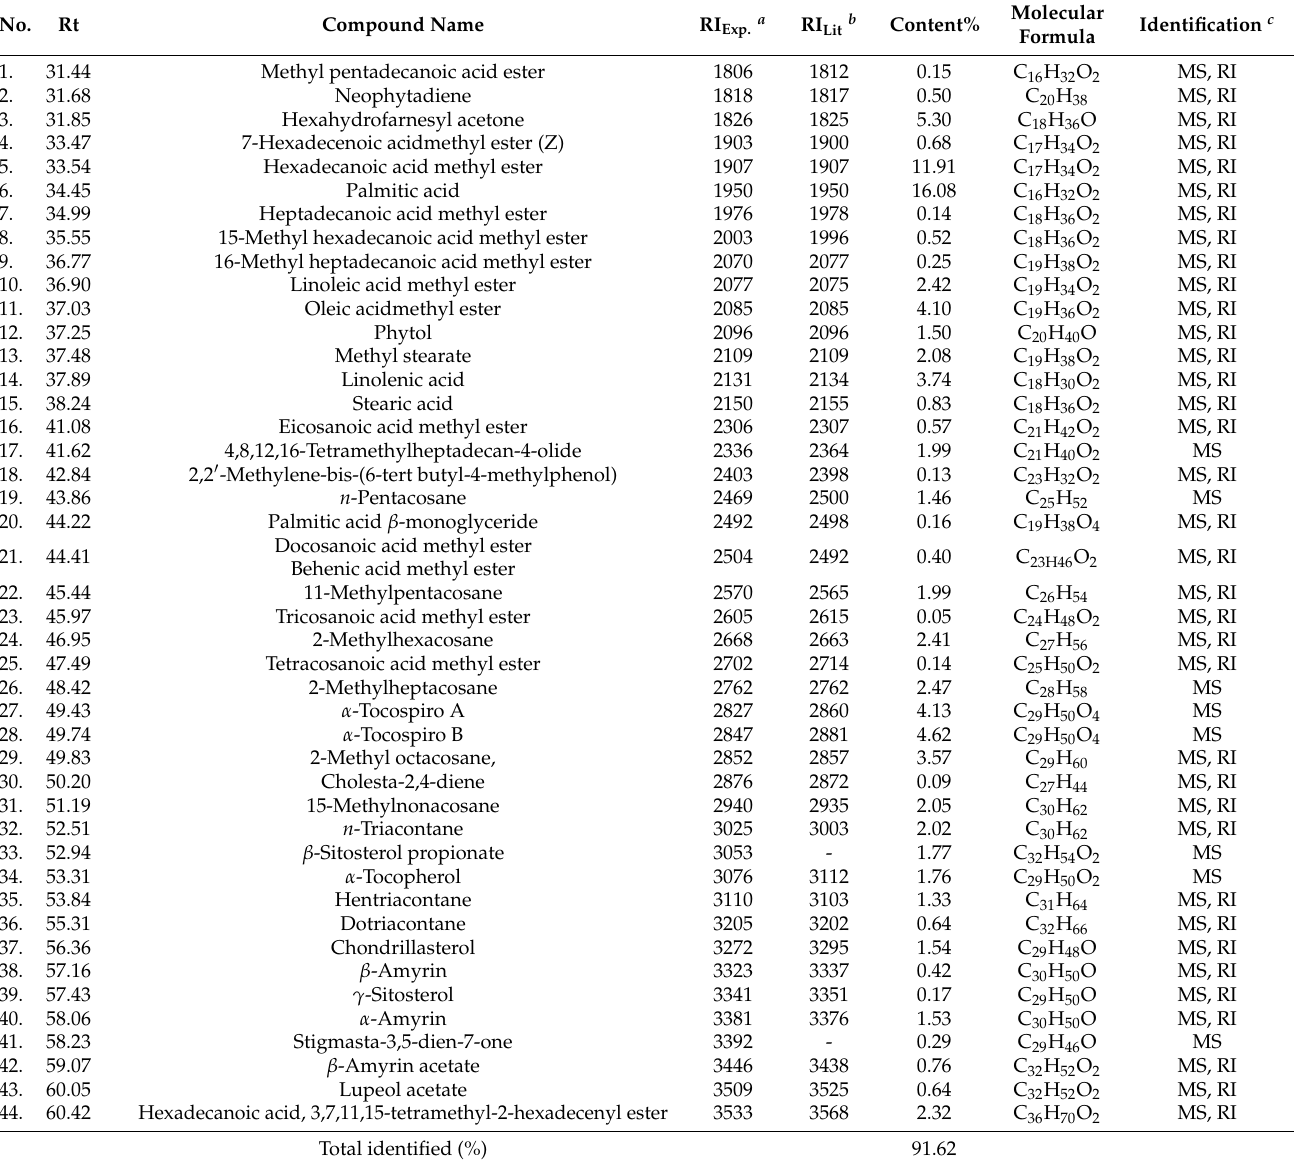
Table 1. Chemical profile of C. aethiopica L. n -hexane fraction (CAL-A) by